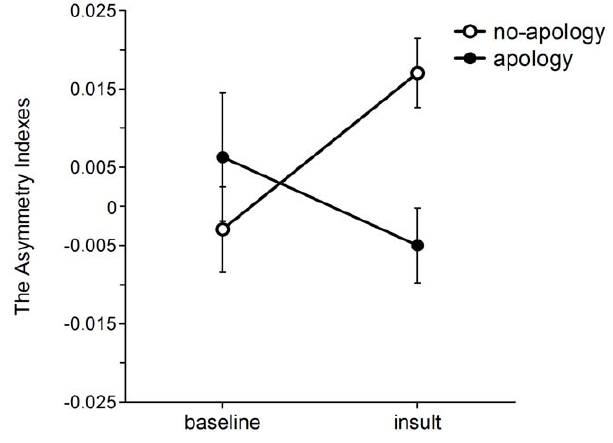
Figure 1. The asymmetry indexes for each group were displayed in the baseline and the insult periods. The open circles illustrate the no-apology group ( N =24). The closed circles illustrate the apology group ( N =24). Each vertical line illustrates the standard error for each condition.